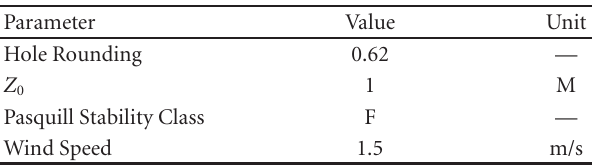
Table 3: The table shows four key parameters for cloud weight modelling in EFFECTS. Hole rounding represents the edges of the hole within TPDIS. Z 0 is surface roughness, given in accordance to Hanna [18] which gives the range 0.9–1.3 for a typical refinery. Pasquill Stability F means extremely stable weather. Wind speed is self-explanatory.